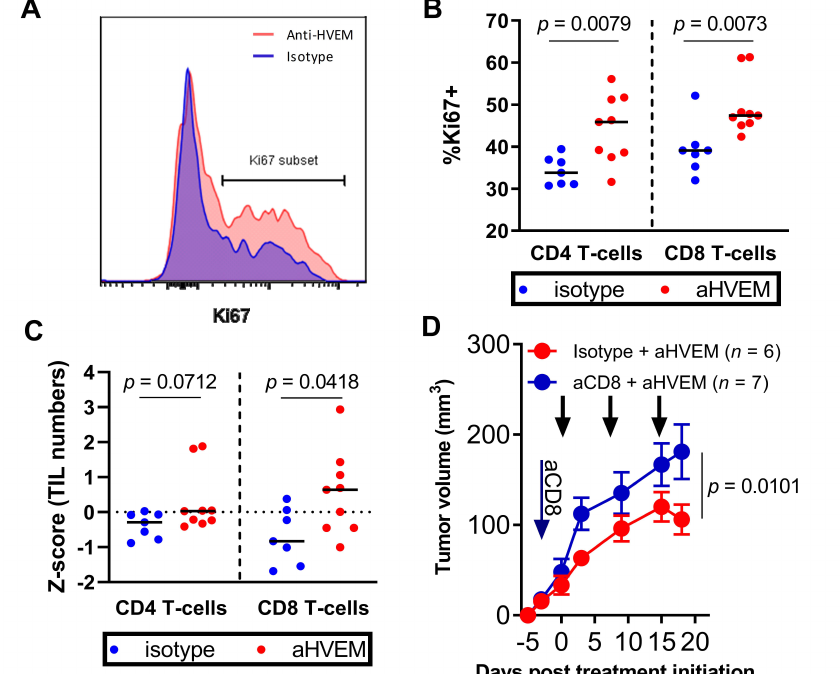
Figure 3. Tumor control was dependent on CD8 + T cells. ( A ) Representative histogram of Ki67 staining. ( B ) Frequencies of Ki67-expressing cells among CD4 + and CD8 + T cells in the tumor. Data are cumulative of two independent experiments performed at D21 post-humanization. ( C ) Absolute numbers of CD4 + and CD8 + T cells in PC3 tumors from two independent experiments. To allow comparison, we converted numbers obtained in each mouse to z-scores (number of standard errors separating the samples from the mean). Each dot is a mouse. The p -value on the graphs is the result of a Mann–Whitney non-parametric t -test. ( D ) Growth of the PC3 cell line in humanized mice treated with anti-HVEM mAb and depleted or not of their CD8 T cells. CD8 T cells were depleted on the day following humanization (blue arrow). Curves are the mean tumor volume ( ± SEM) in the indicated number of mice. Black arrows indicate the time of anti-HVEM mAb injection. Data are cumulative of two independent experiments. The p -value reported on the graphs tests the null hypothesis that the slopes are all identical using a linear regression